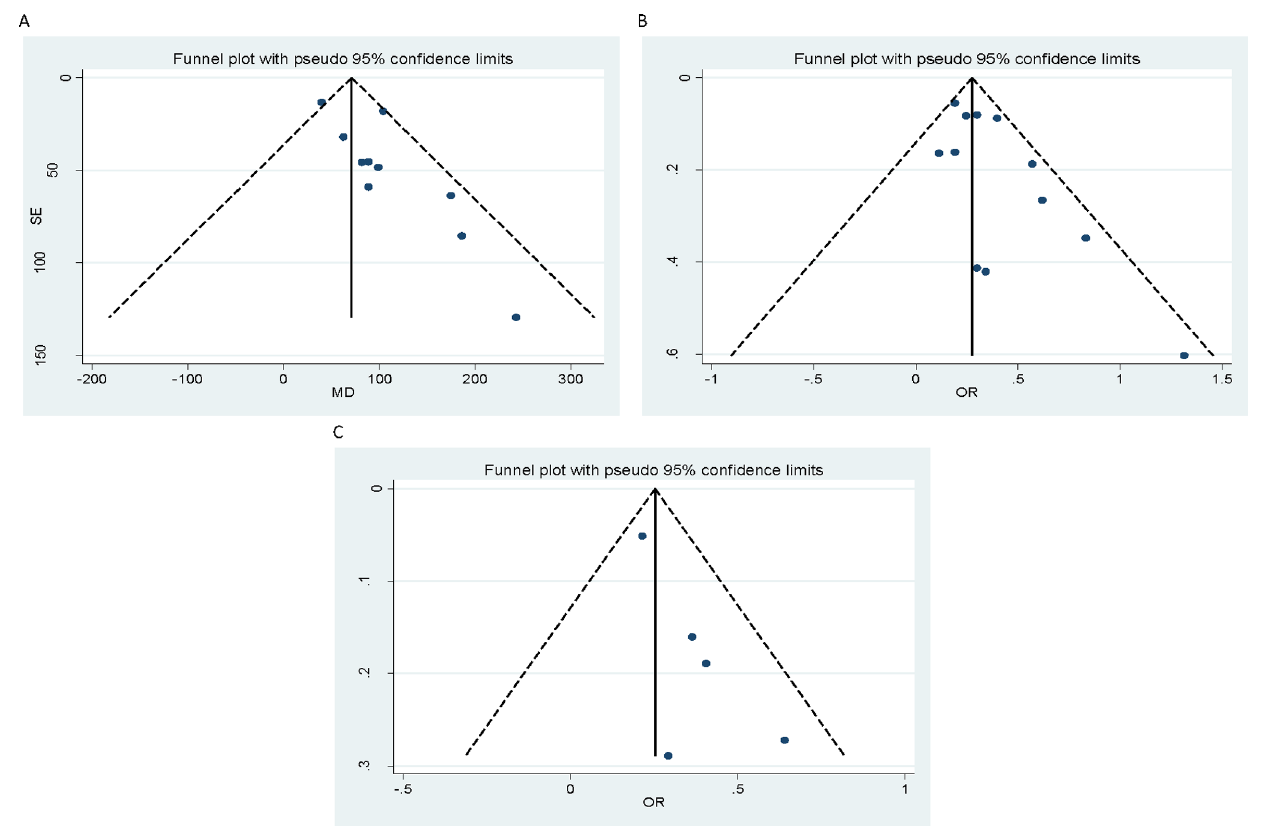
Figure 3. Funnel plot for the relation between household solid fuel use and birth weight (A), low birth weight (B) and stillbirth (C).